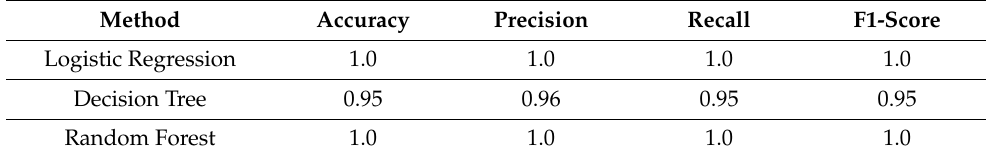
Table 6. Classification report for the supervised methods—flow data.